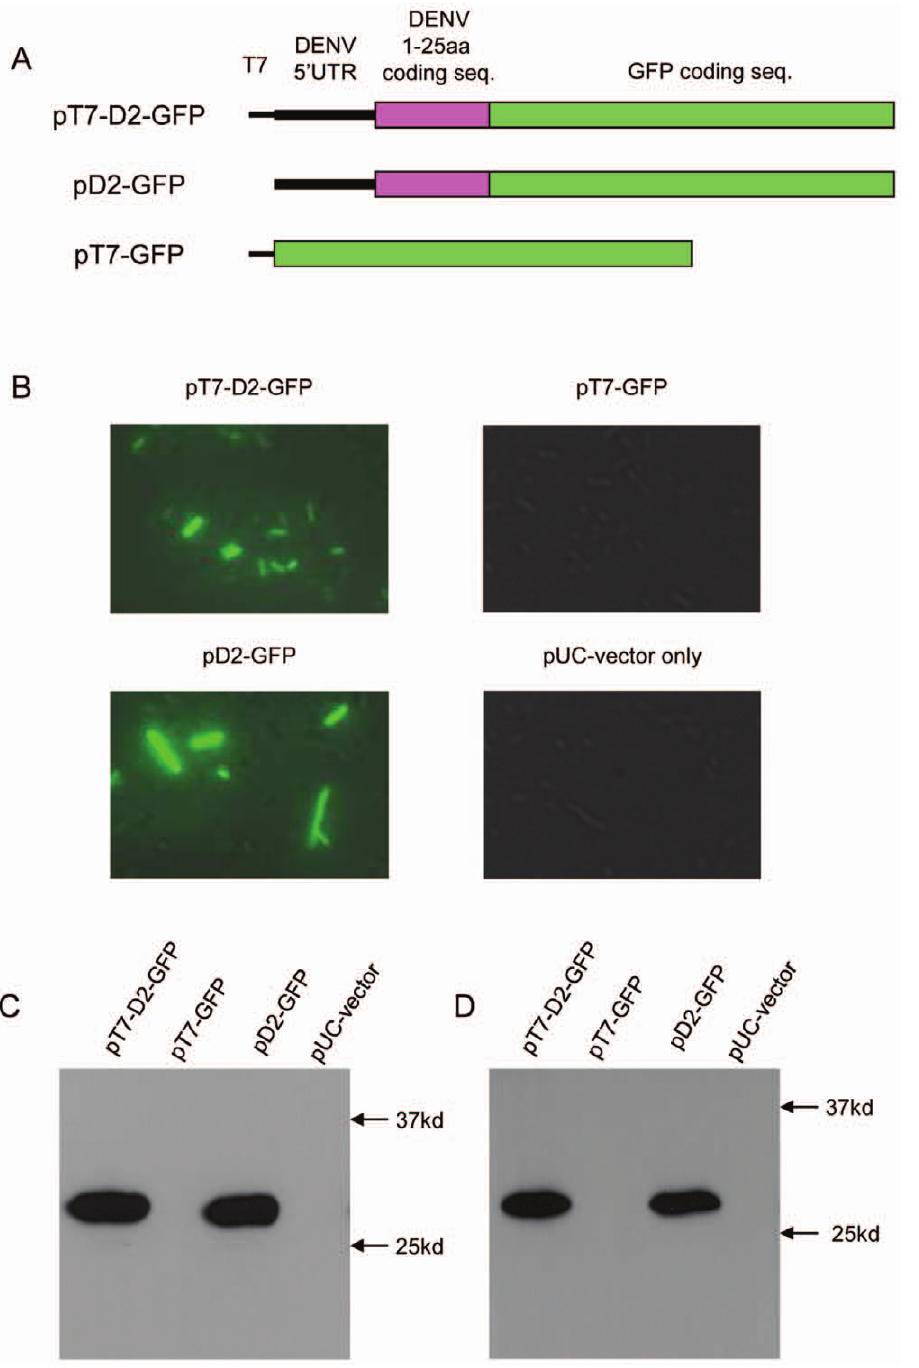
Figure 1. Expression of D2-GFP fusion protein in E.coli (DH5 a ) is driven by a cryptic promoter in the cDNA encoding the 5 9 1–170 nt of DENV2 RNA genome. (A) Schematic for the constructs of pT7-D2-GFP, pD2-GFP and pT7-GFP. (B) Florescence microscopy images of E. coli cells transformed with these plasmids. (C) Western blot analyses of transformed E. coli lysates employing 6F3.1 anti-dengue 2 virus core protein monoclonal antibody. (D) Western blot analyses of transformed E. coli lysates employing the anti-GFP antibody.